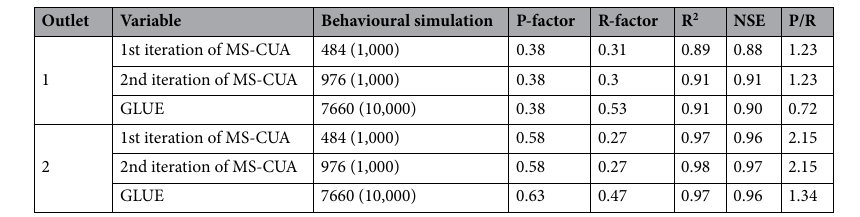
Table 2. The comparison results between the simplified MS-CUA method and GLUE. *P-factor: the percentage of observations covered by the 95PPU. *R-factor: the measure of the relative width of 95% probability